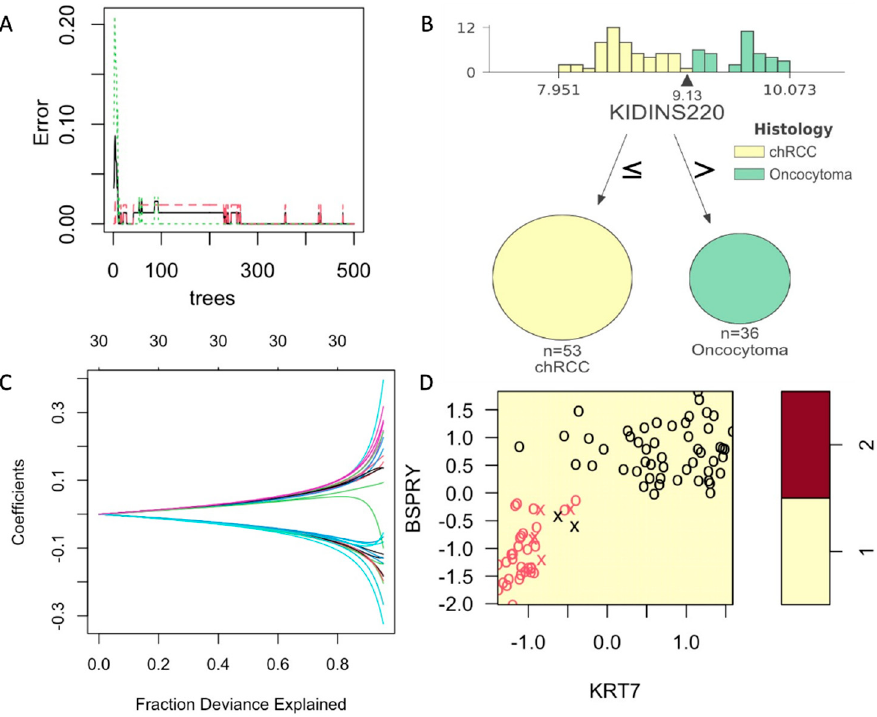
Figure 3. Supervised models with training on COGS discovery data and tested on NanoString data. ( A ): Figure 3: Development and comparison of four supervised models. Random Forest models showing a minimum of 250 trees can achieve the error = 0. ( B ): A sample tree showing the distribution of gene KIDINS220 expression on COGS discovery data with the arrow pointing at the best cutoff value. ( C ): A sample support vector model with KRT7 and BSPRY . ( D ): Generalized linear model with Ridge regression showing the fraction explained by the COGS genes as covariates. All these metrics show the results on NanoString data (AUMC cohort).